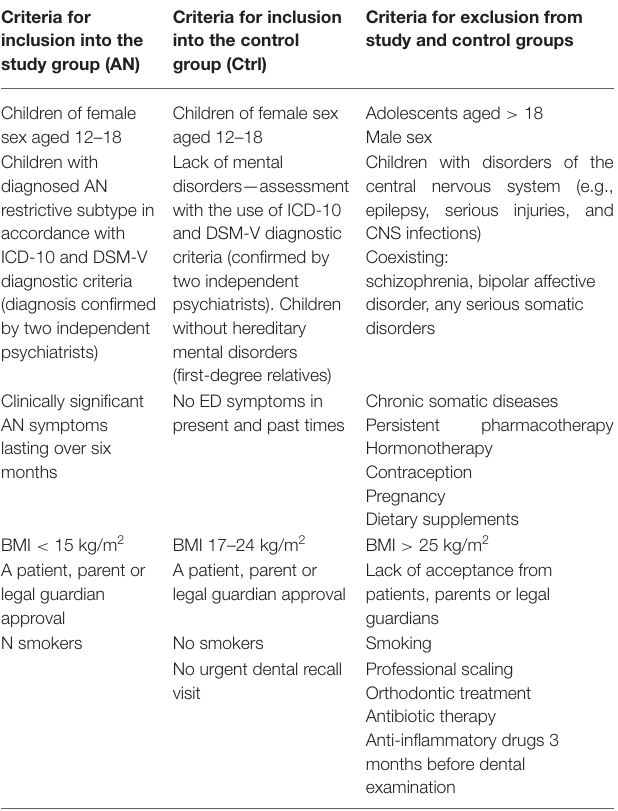
Criteria for exclusion from study and control groups